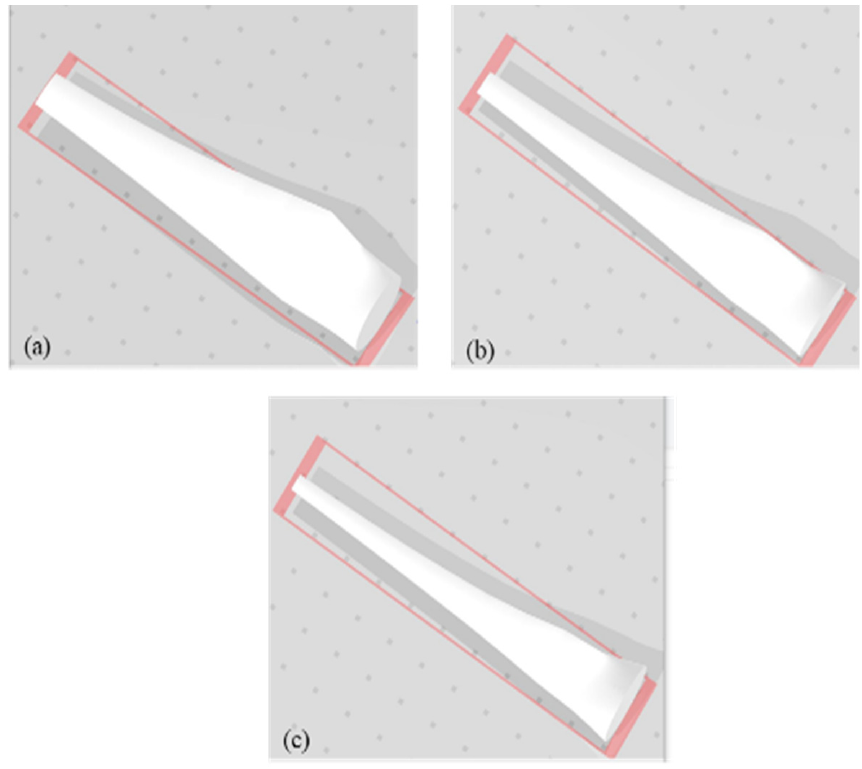
Figure 13. 3-D blade model designed with SG6043 airfoils for ( a ) TSR 4; ( b ) TSR 5; ( c ) TSR 6.